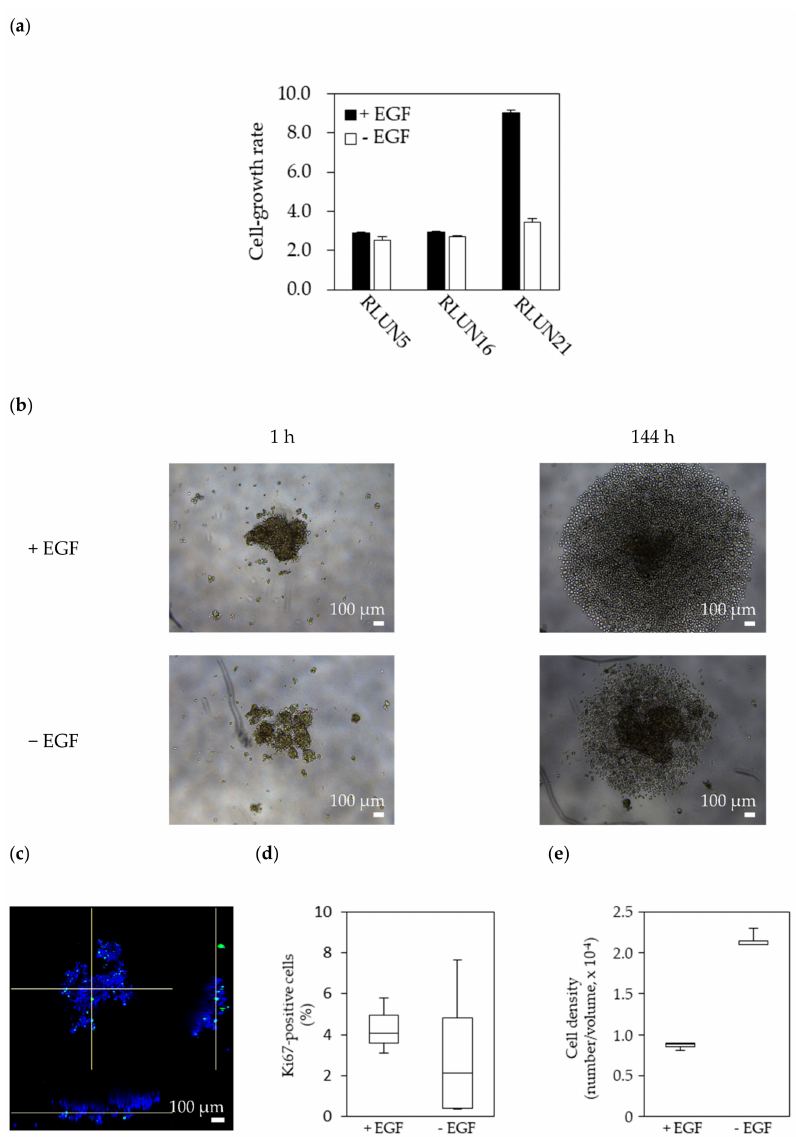
Figure 3. Dependency of F-PDO proliferation on epidermal growth factor (EGF). ( a ) Growth rate of RLUN5, RLU16, and RLUN21 in the presence or absence of EGF. Each F-PDO was seeded in a 96-well, round-bottomed, ultra-low-attachment microplate (Corning, Inc.). Twenty-four hours after seeding, EGF was added into the wells at a final concentration of 100 ng / mL. The wells without EGF were also set up to confirm the dependency of cell growth on EGF. One hour (culture start time) or 144 h later, the amount of ATP was measured as described in Section 2.6. Growth rates were calculated by dividing the amount of ATP in each well at 144 h by that at the culture start time. ( b ) Phase-contrast images of RLUN21 cultured with EGF (upper panels) or without EGF (lower panels) for six days. The images were obtained using a × 5 objective. Scale bar: 100 µ m. ( c ) Images of Ki67 expression in RLUN21 cultured with EGF were obtained using an anti-Ki67 antibody (green). DNA stained with DAPI (blue). Magnification: × 10. Scale bar: 100 µ m. Box-and-whisker plot of the Ki67-positive ratio ( d ) and cell density ( e ) of RLUN21 cells cultured with